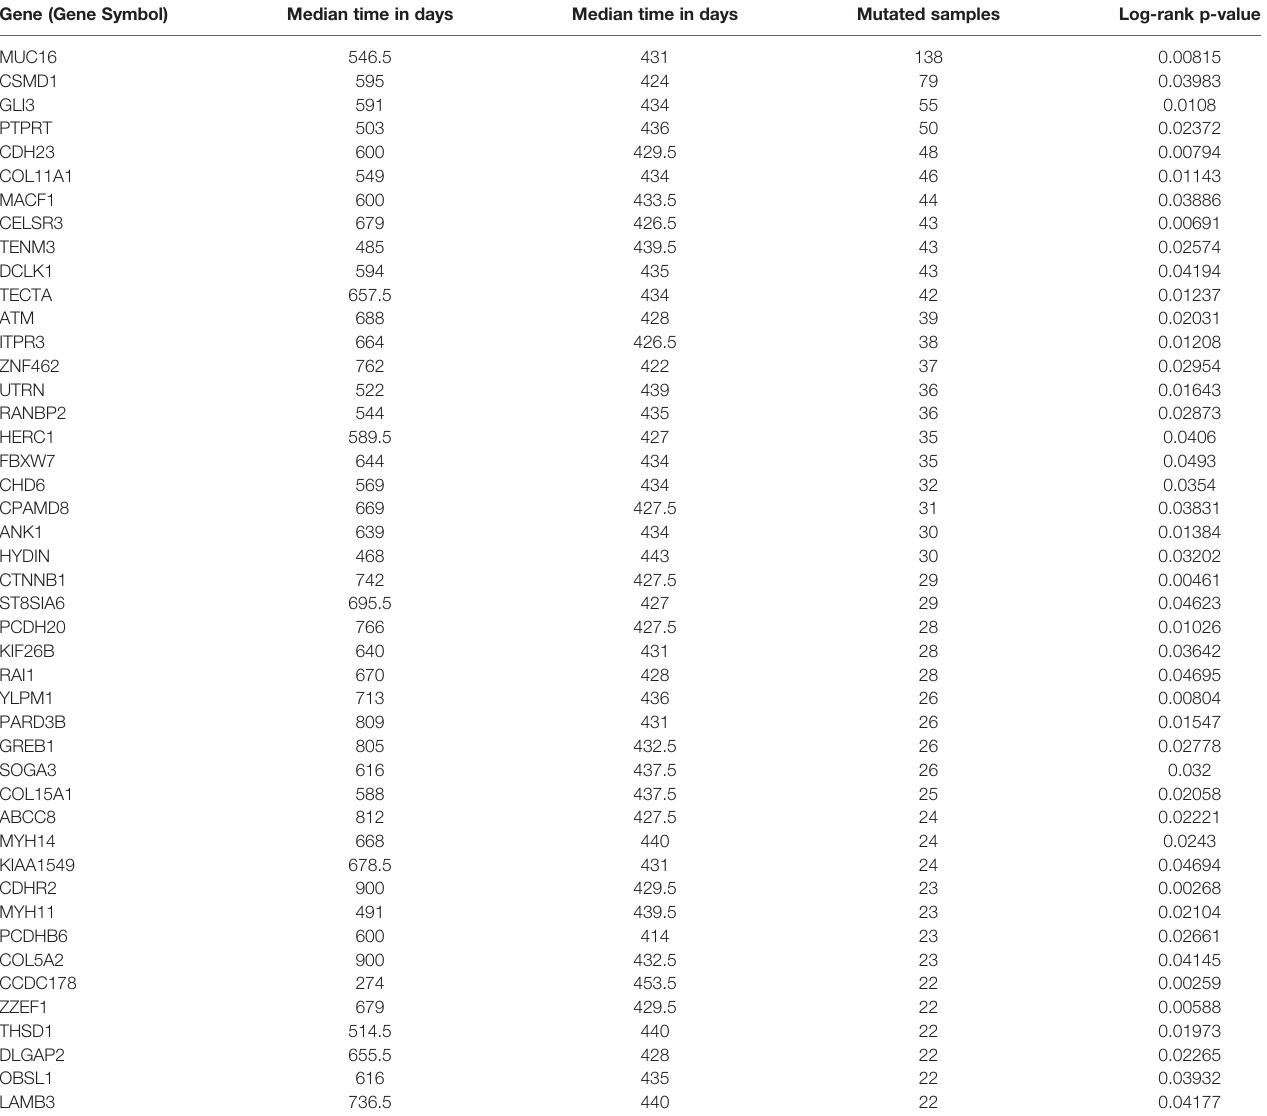
TABLE 1 | Survival-related mutated genes by Kaplan – Meier survival analyses. Gene (Gene Symbol) Median time in